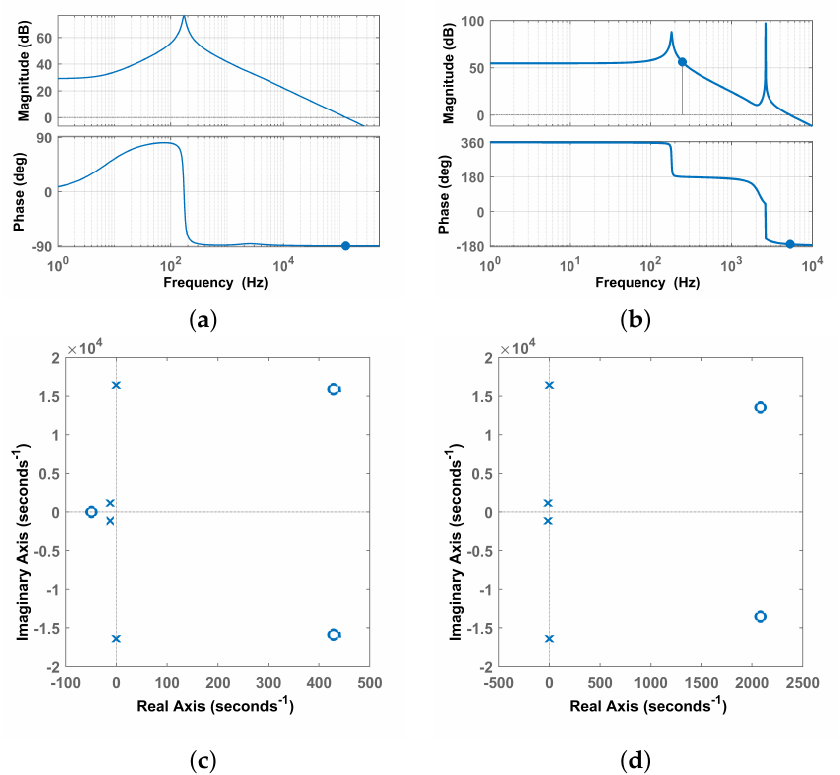
Figure 3. TF boost mode for ( a ) Bode plot Gi L 1 d _ u ( s ) . ( b ) Bode plot Gvd _ u ( s ) . ( c ) Pole and zero map for Gi L 1 d _ u ( s ) . ( d ) Pole and zero map for Gvd .